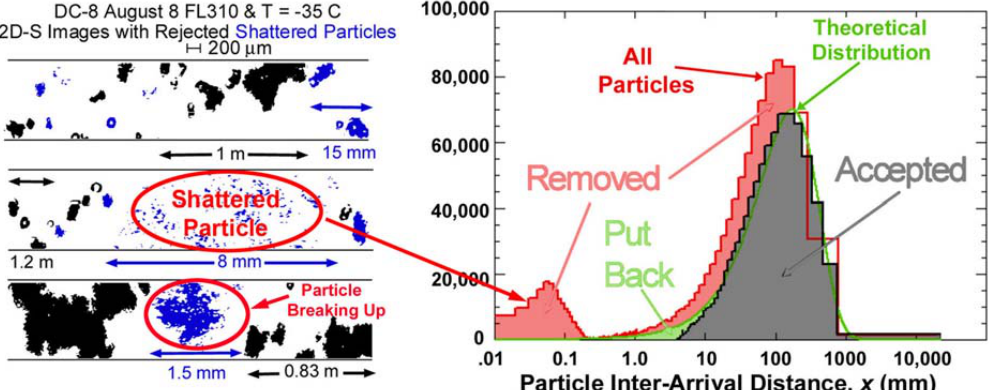
Fig. B3. Example of (left) 2D-S images in ice with particles in blue identified as artifacts using the algorithms described in this Appendix, and (right) plot of particle events versus inter-arrival distance showing (in red) the inter-particle distances before removing shatterers, (in black-grey) the remaining (“Accepted”) particles’ inter-particle distances after “Removing” shatterers, and (in green) an exponential distribution with the same mean as the after-shattering removal distribution, for comparison (labeled “Theoretical Distribution”). For the sake of simplicity in nomenclature, the difference between the black and green distributions is what is labeled “Put Back”, but in reality the results are adjusted by the factor SV adj , as described in the text.